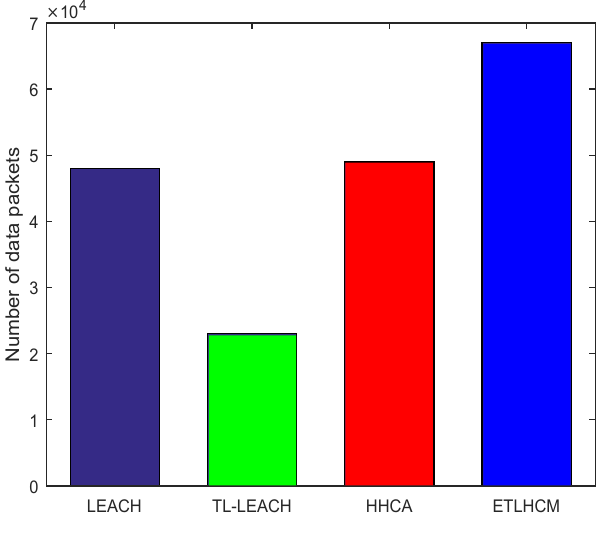
Figure 5. Total number of received data packets at base